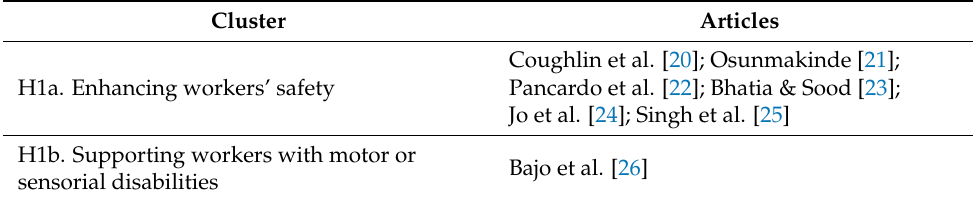
Table 2. Articles clustered according to the type of support they described for the AW. Cluster Articles H1a. Enhancing workers’ safety H1b. Supporting workers with motor or sensorial